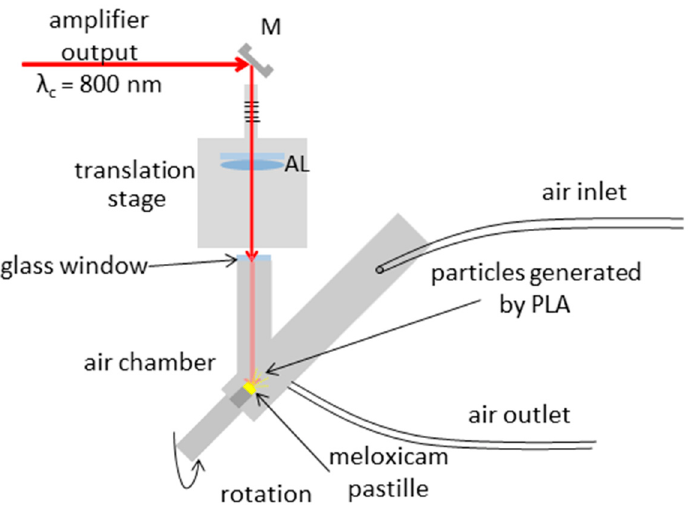
Figure 1. Experimental setup for pulsed laser ablation in air. M: silver mirror, AL: achromatic lens. The laser spot size on the target surface, determined by measuring the horizontal dimensions of the ablated holes by optical microscopy, was found to be 111 and 157 µm, denoting the 1/e 2 beam radii along the minor and major axes, respectively. Pulse energy values were recorded by an energy meter. The applied average laser fluence reaching the target was varied between 0.7 and 1.5 J/cm 2 by adjusting the output energy of the amplifier.